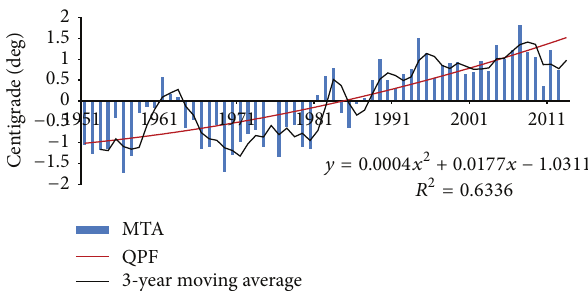
Figure 2: The Mean Temperature Anomaly (MTA), Quadratic Poly- nomial Fitting (QPF), and a 3-year moving average of the annual mean temperature of Guan Xiang Tai (GXT) in the period of 1951–